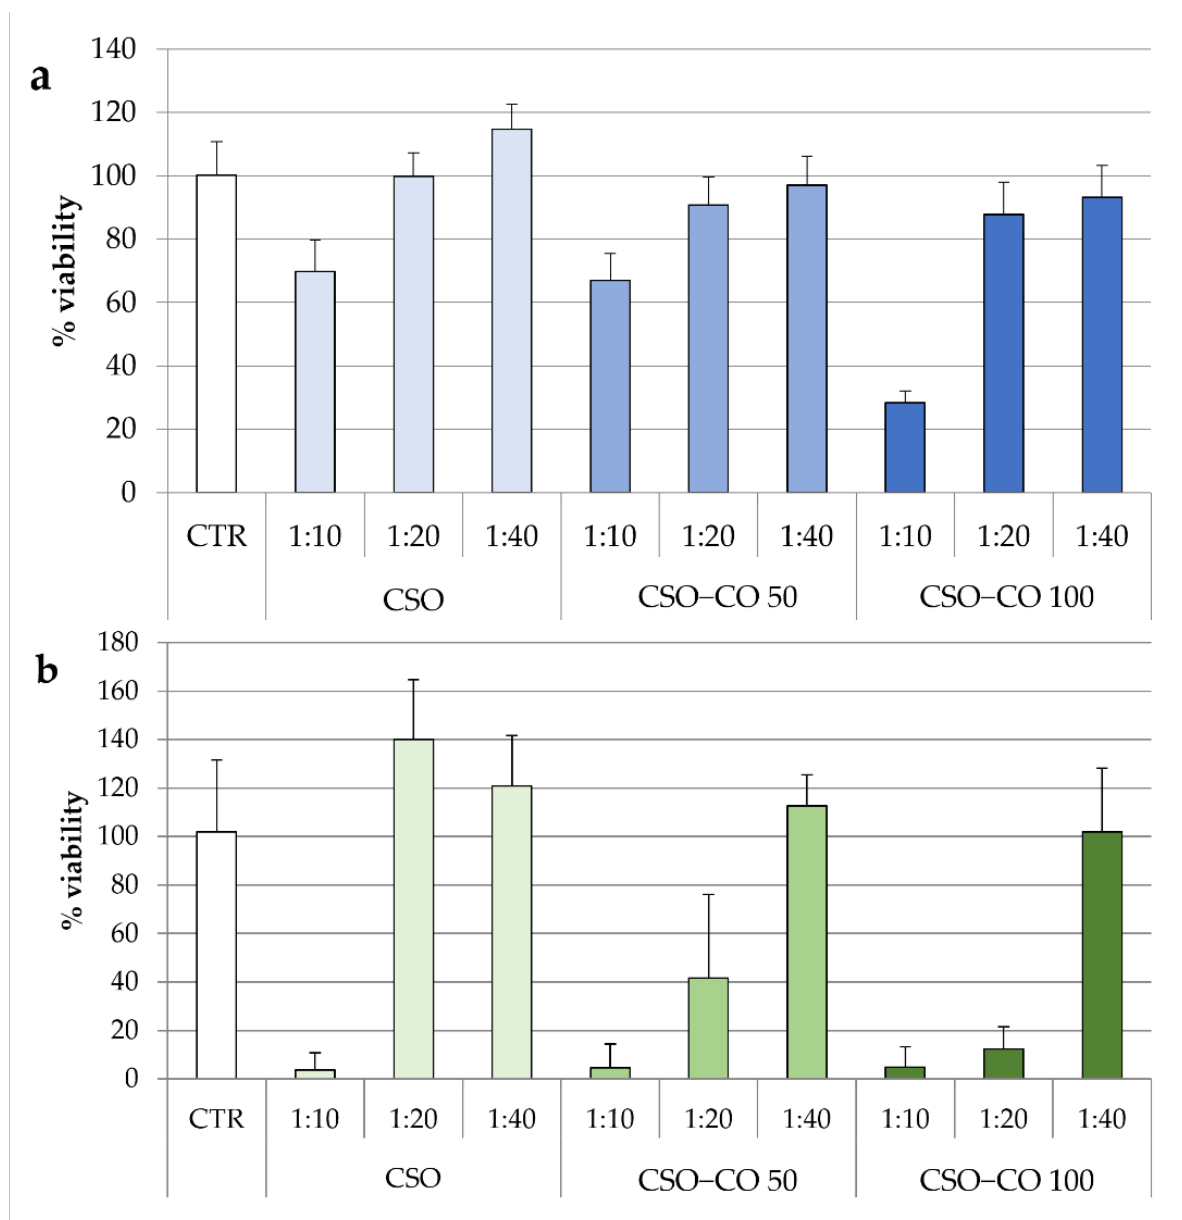
Figure 8. Fibroblast viability after 3 h ( a ) and 24 h ( b ) of treatment with unloaded CSO as a blank and with the CSO–CO 50 and CSO–CO 100 NE samples at different dilutions with culture medium (1:10, 1:20, and 1:40 v / v ) (mean ± sd; n = 8).